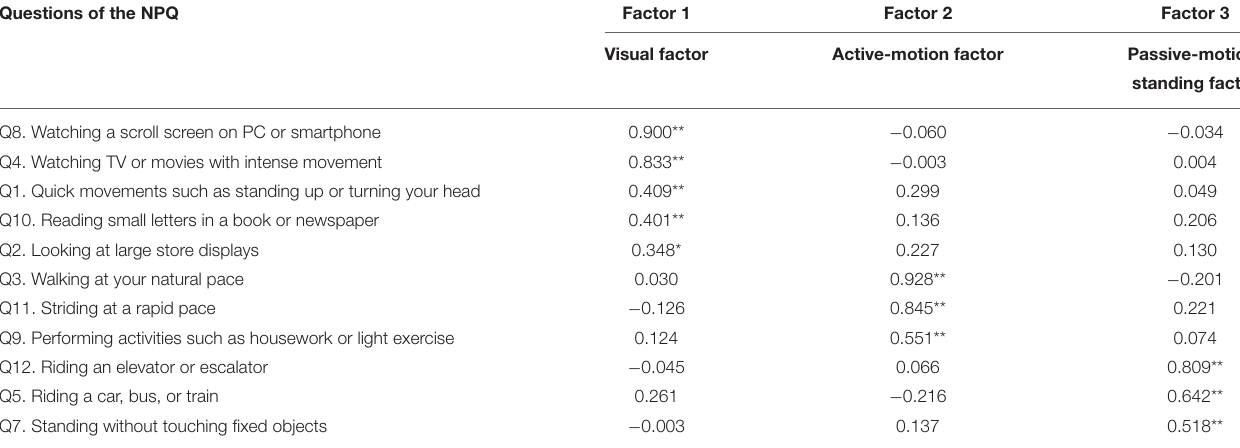
TABLE 3 | The factor analysis performed on the Niigata PPPD Questionnaire (NPQ) scores. Questions of the